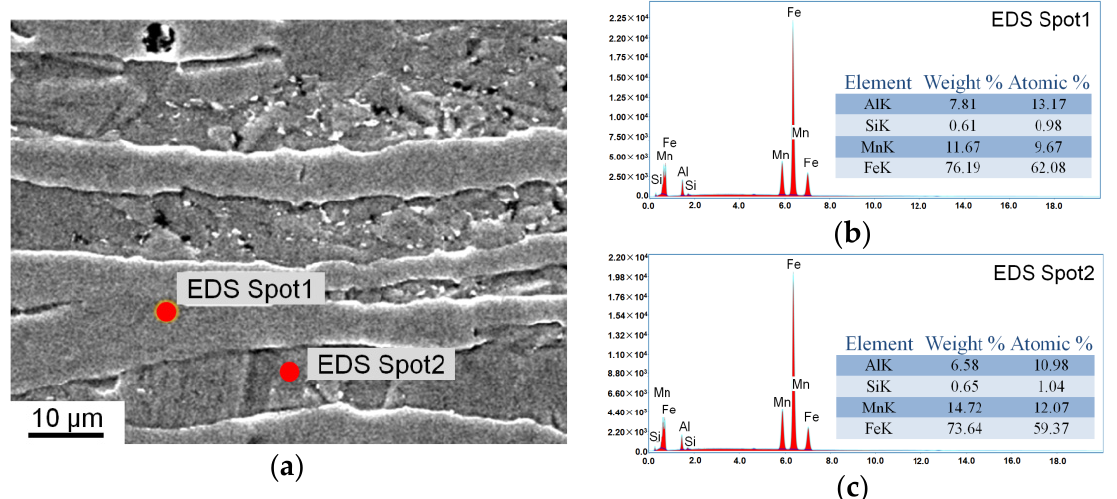
Figure 7. ( a ) Scanning electron micrograph of the location of the EDS spots and elemental analysis result of ( b ) spot 1 and ( c ) spot 2.